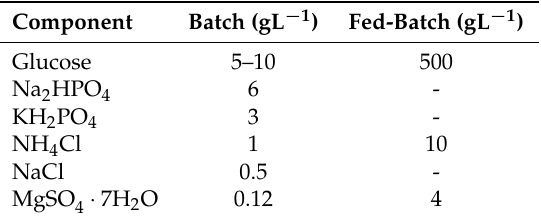
Table 8. Composition of the M9